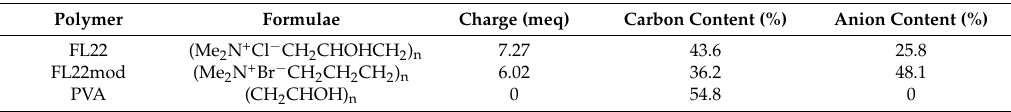
Table 1. Polymer description: cationic charge, ideal formulae, and the carbon, chloride/bromide content are % by